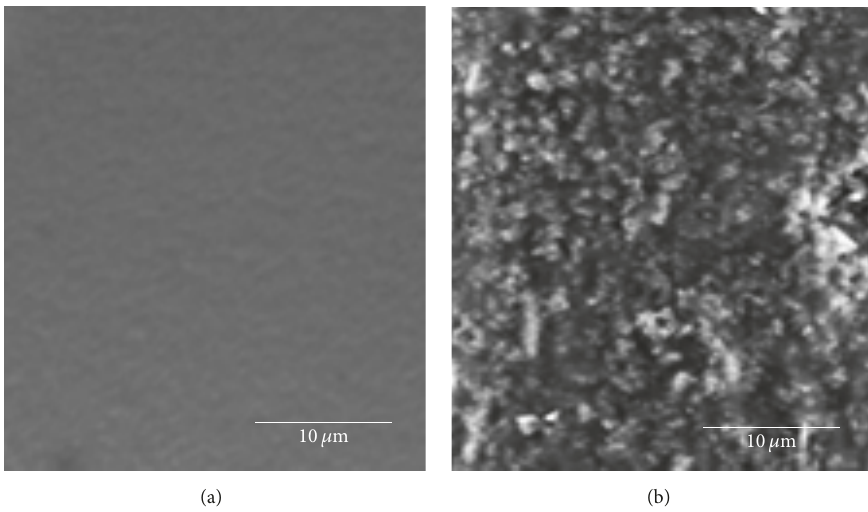
Figure 5: SEM images of the HEC films filled with organobentonite, wt.% of filler: (a) – 0; (b) – 3.